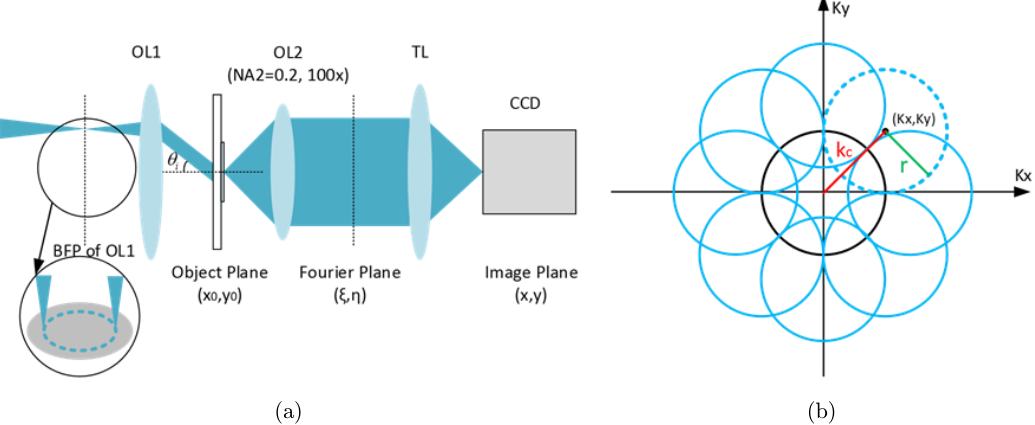
Fig. 1. Schematic of synthetic aperture. (a) Schematic diagram of synthetic aperture by tiled illumination to improve the reso- lution of the microscope. (b) Synthesis of spatial spectrum in the pupil